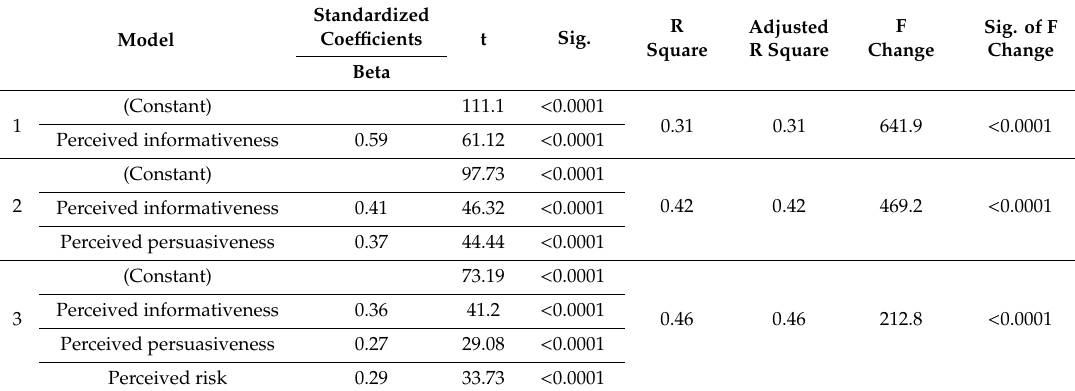
Table 5. Results of the step-wise regression